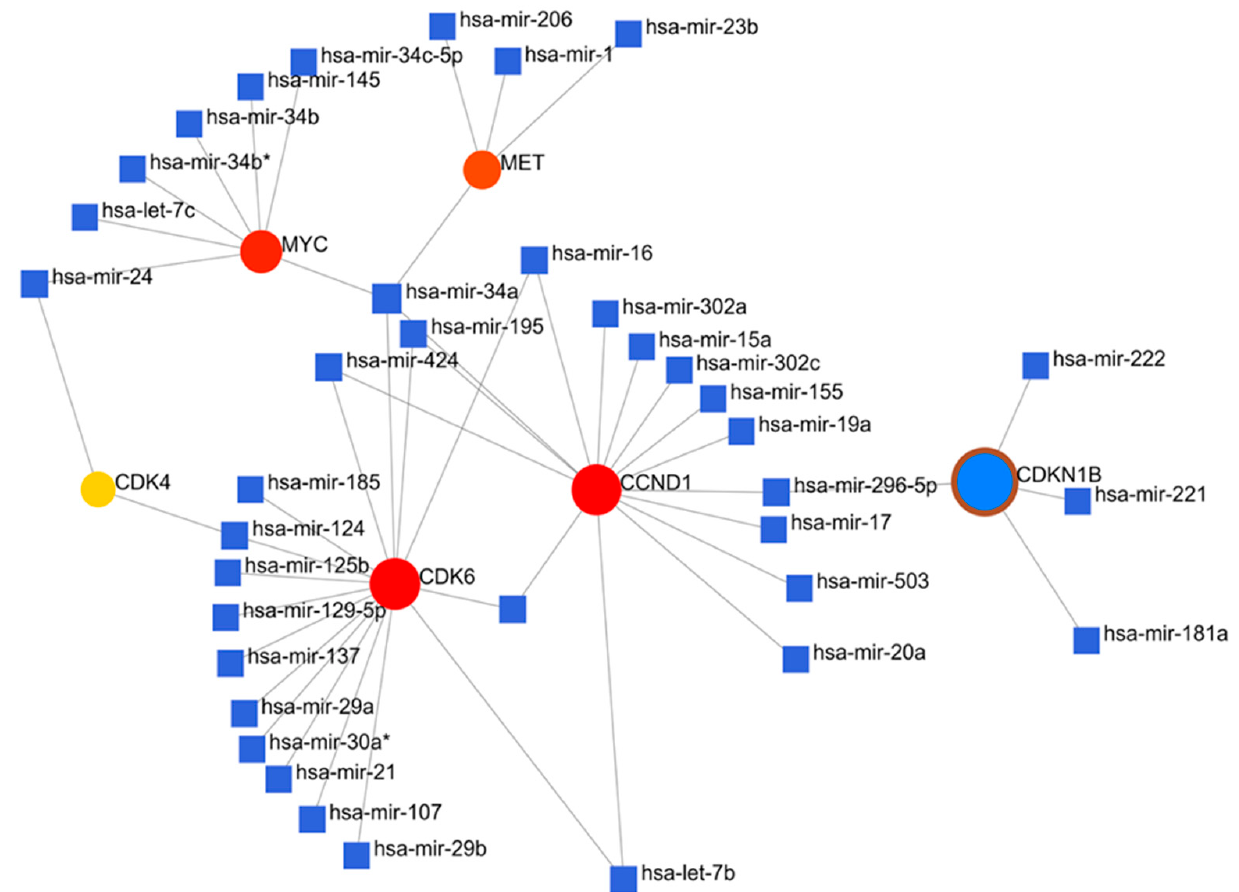
Figure 4. Network topology profiling of miRNAs that targets c-Met, GSK3 β , MYC, and CCND1 oncogenes specifically, with * p < 0.05 considered statistically significant.